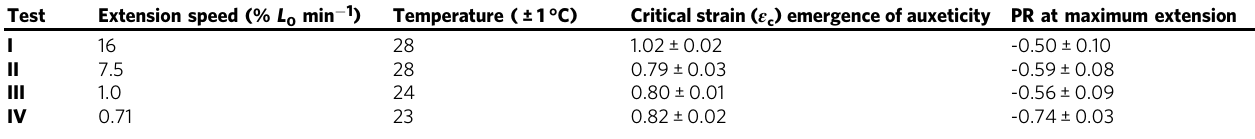
Error on temperature readings based on range of readings from three thermocouples distributed around the samples. Errors on ε c indicate measurement error on strains measured at the emergence of auxeticity for each test ( n = 1). Errors for PR at maximum extension described in the methods section ( n =